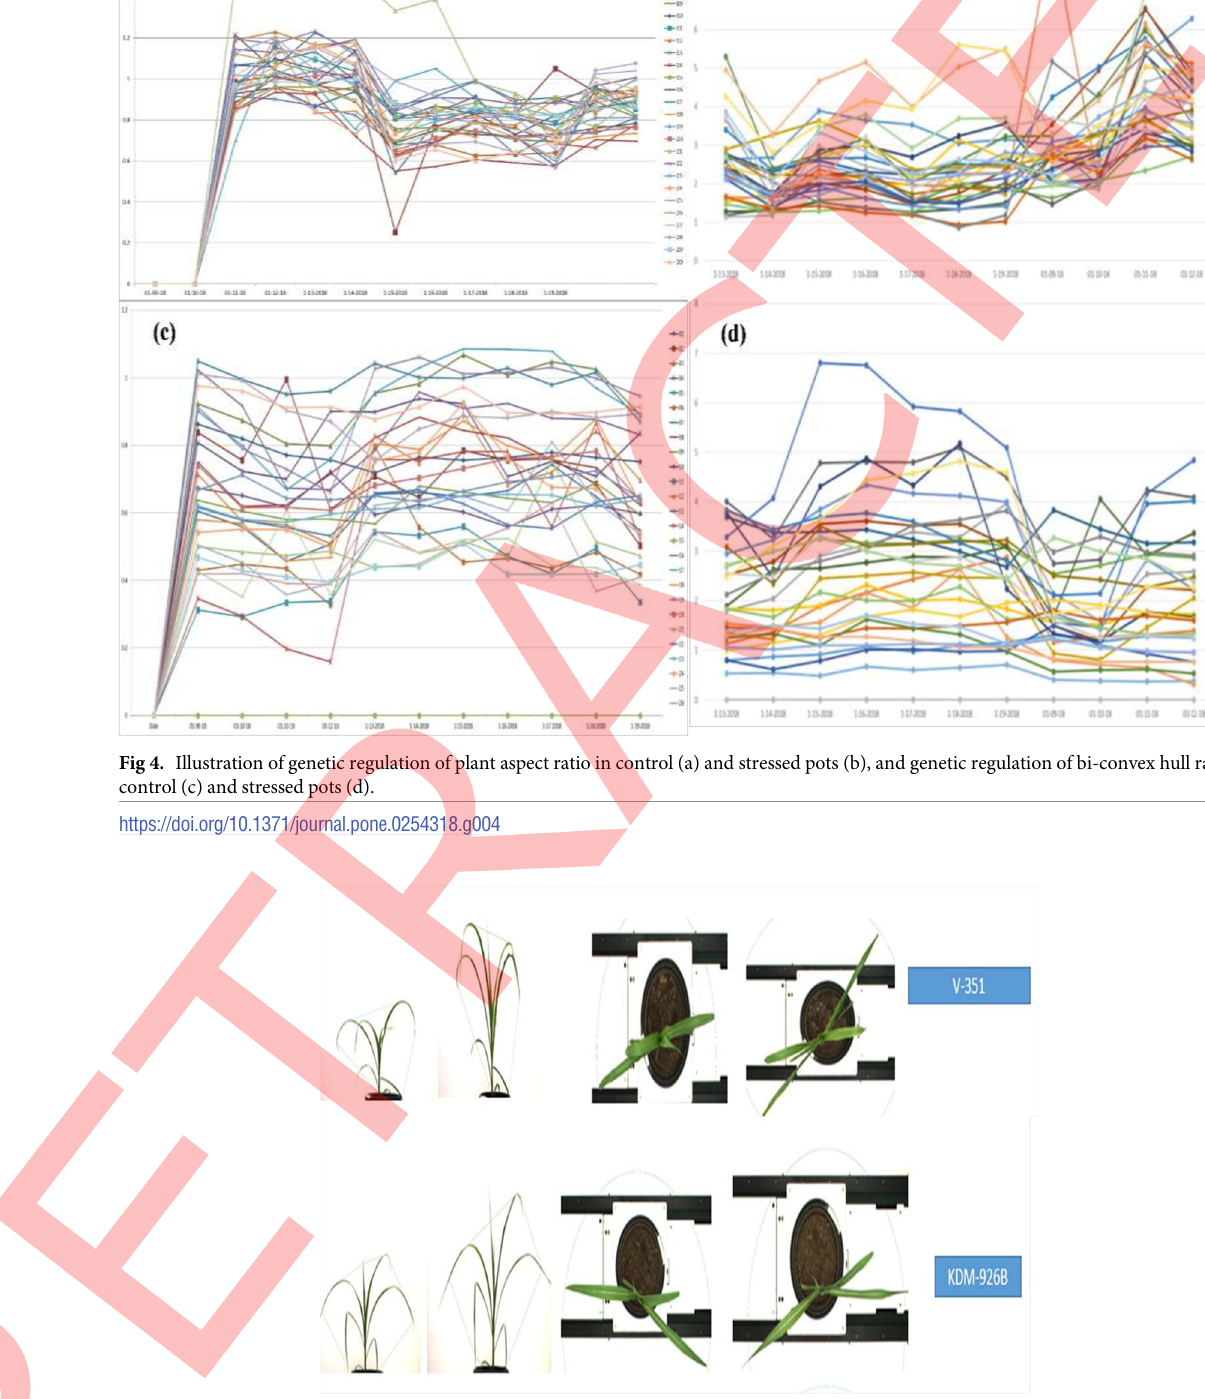
Fig 5. Top ranking aspect ratio lines in control and stressed pots.